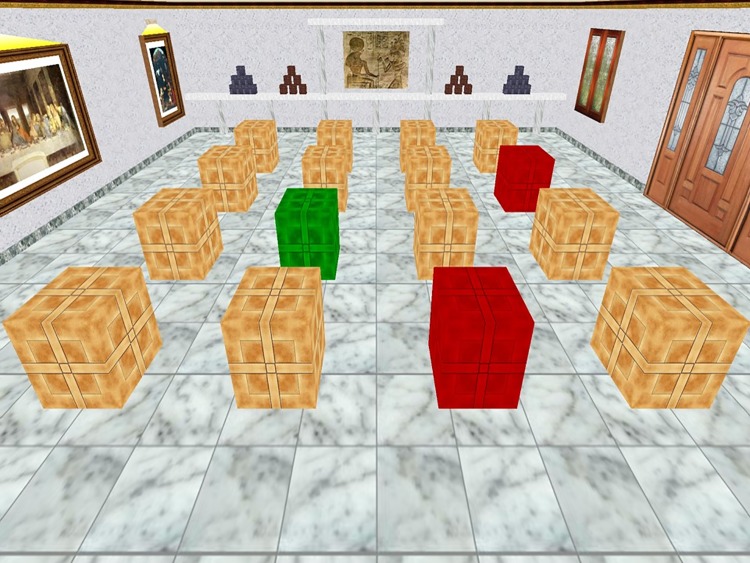
NWSBRT.Representative view of the virtual room. Note that the context is similar to WSBRT. Now, each participant opened the brown boxes with a double-click on the mouse. Green indicated a reward box was opened and red indicated a non-reward one.